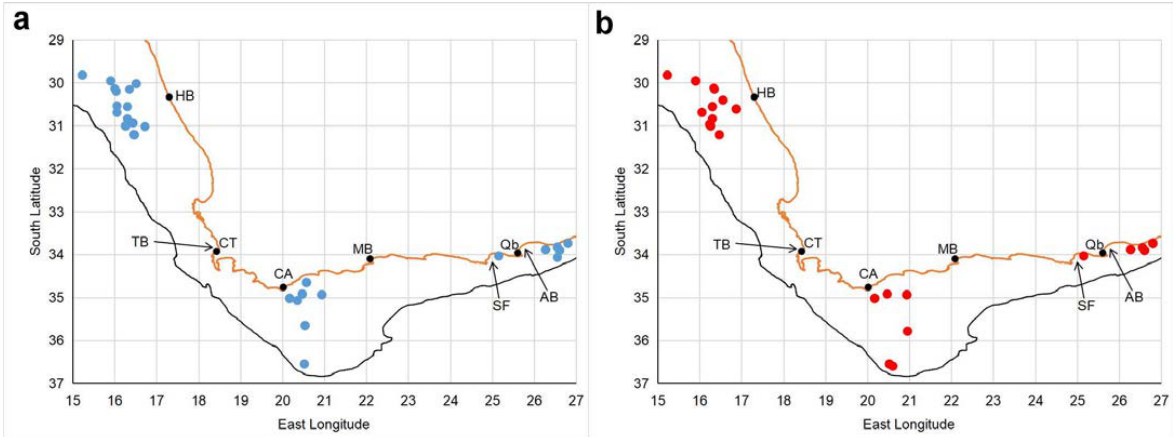
Figure 1. Collection localities for male ( a ) and female ( b ) Sepia typica specimens analysed for mor- phological variation. AB = Algoa Bay, CA = Cape Agulhas, CT = Cape Town, HB = Hondeklip Bay, MB = Mossel Bay, Qb = Gqeberha (formerly Port Elizabeth), SF = St Francis Bay, TB = Table Bay (type locality). Dots represent stations where specimens were collected. Orange line represents coastline, and black line the 500 m